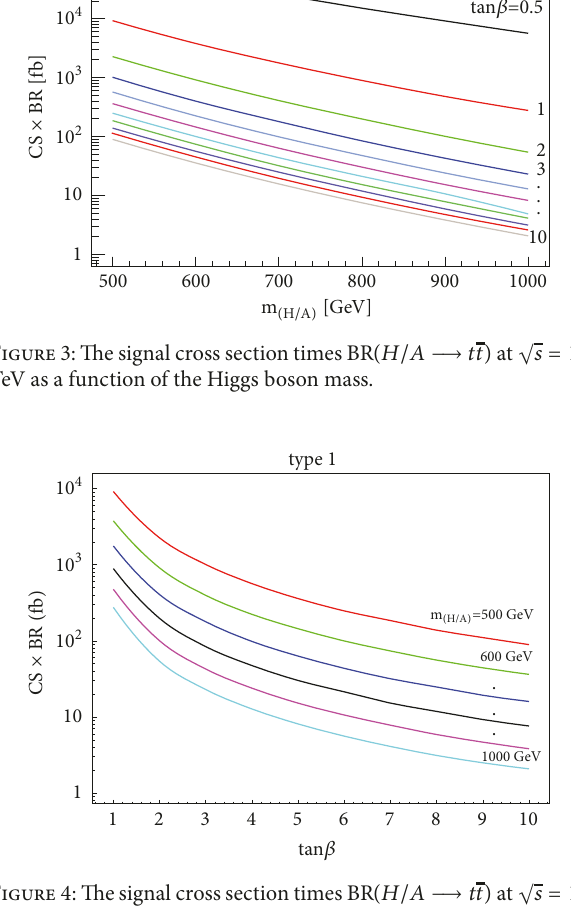
Figure 4: The signal cross section times BR (𝐻/𝐴 󳨀→ 𝑡𝑡) at √𝑠 = 14 TeV as a function of tan 𝛽